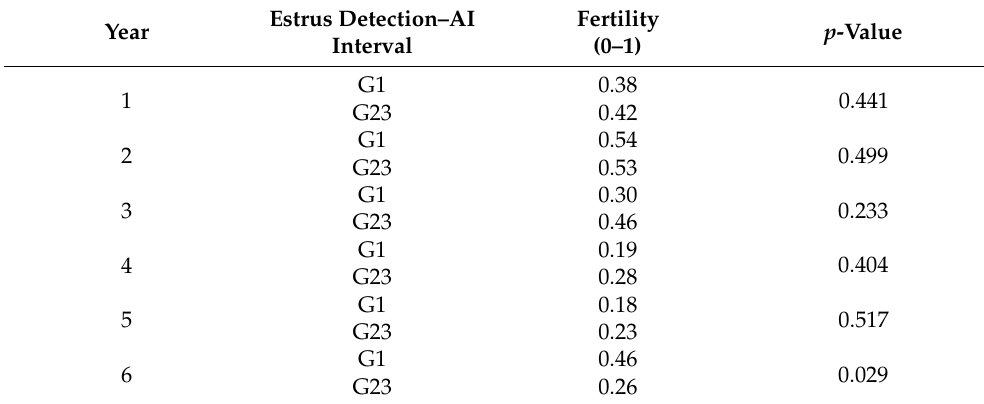
p -Value 0.441 0.499 0.233